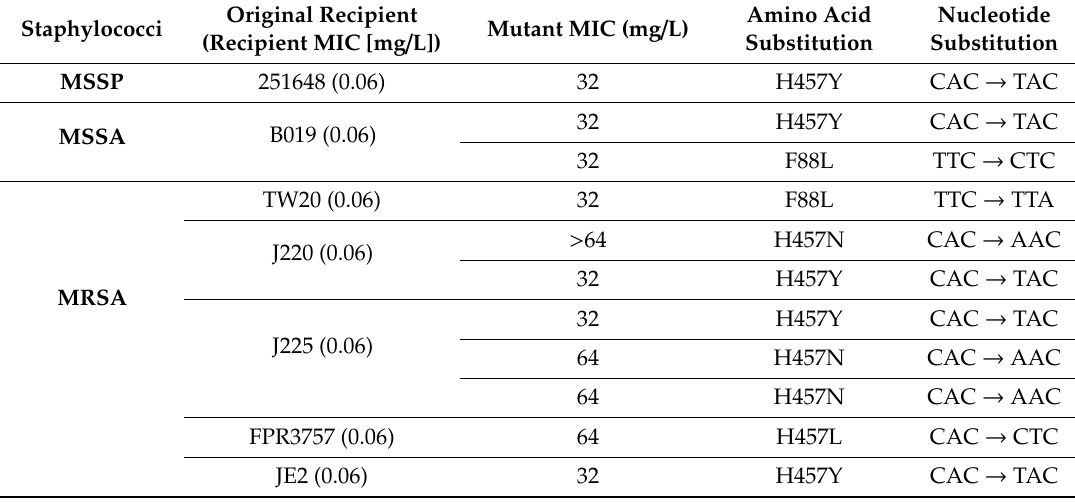
Table 3. Fusidic acid minimum inhibitory concentrations (MIC) and mutations in fusA (including the novelpositionF88L)afterexposureofMRSA,MSSA,andMSSPtosubinhibitoryconcentrationsoffusidic acid. PCR confirmed species and methicillin-resistance as the same as the original recipient